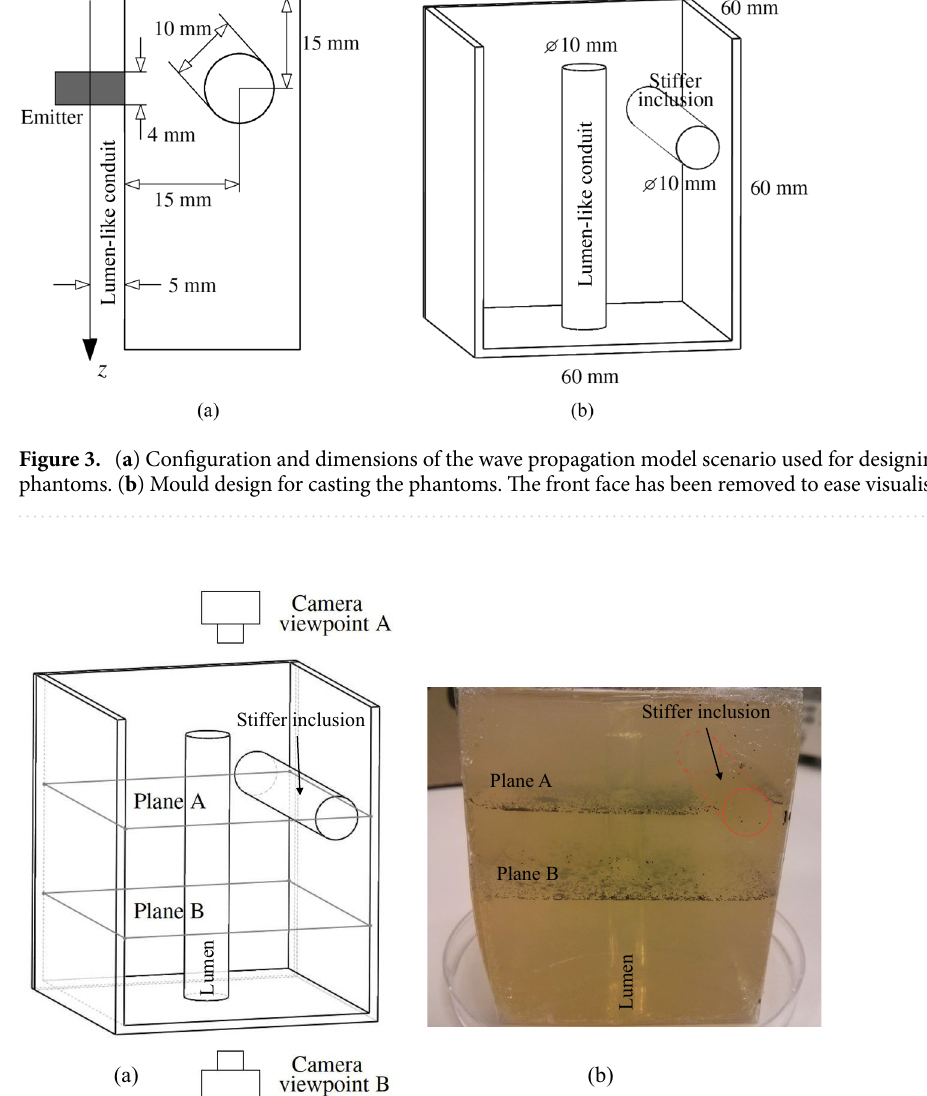
use of an emitter prototype fabricated by University of Granada (Spain) on another collaborative project. The diameter of the emitter was 11 mm. The difference of 1 mm ensured good mechanical contact between emitter and phantom surface. The diameter of the inclusion was also set as 10 mm, a value within the order of the size of prostate tumours 27 . Planar patterns of visible particles of size a fraction of the expected wavelength were embedded in the phan- tom. The visible particles consisted of basalt microspheres (Whitehouse Scientific Ltd., Chester, UK) of sizes between 180 and 212 µ m . Particles were randomly distributed and contained in planes perpendicular to the lumen axis, where the arc-shape particle vibration was better observable (Fig. 1b). The two planes were set at two different z coordinates, as indicated in Fig. 4: one containing the stiff inclusion, labelled as plane A, and another without inclusion labelled as plane B. Three phantoms were fabricated, each one containing an inclusion of different gelatine concentration as indicated in Table 3. The background of all the phantoms was made from the same gelatine batch. The gelatine batch was prepared as follows (quantities are shown in Table 2): (1) K-sorbate was added to the distilled water while stirring; (2) the mixture was heated up at a rate of approximately 1 ◦ C per minute; (3) gelatine powder was gradually added to the mixture until it was fully dissolved; (4) the mixture was covered and heated up to 85 ◦ C at a rate of approximately 1 ◦ C per minute, after which, the temperature was maintain between 85 and 90 ◦ C for